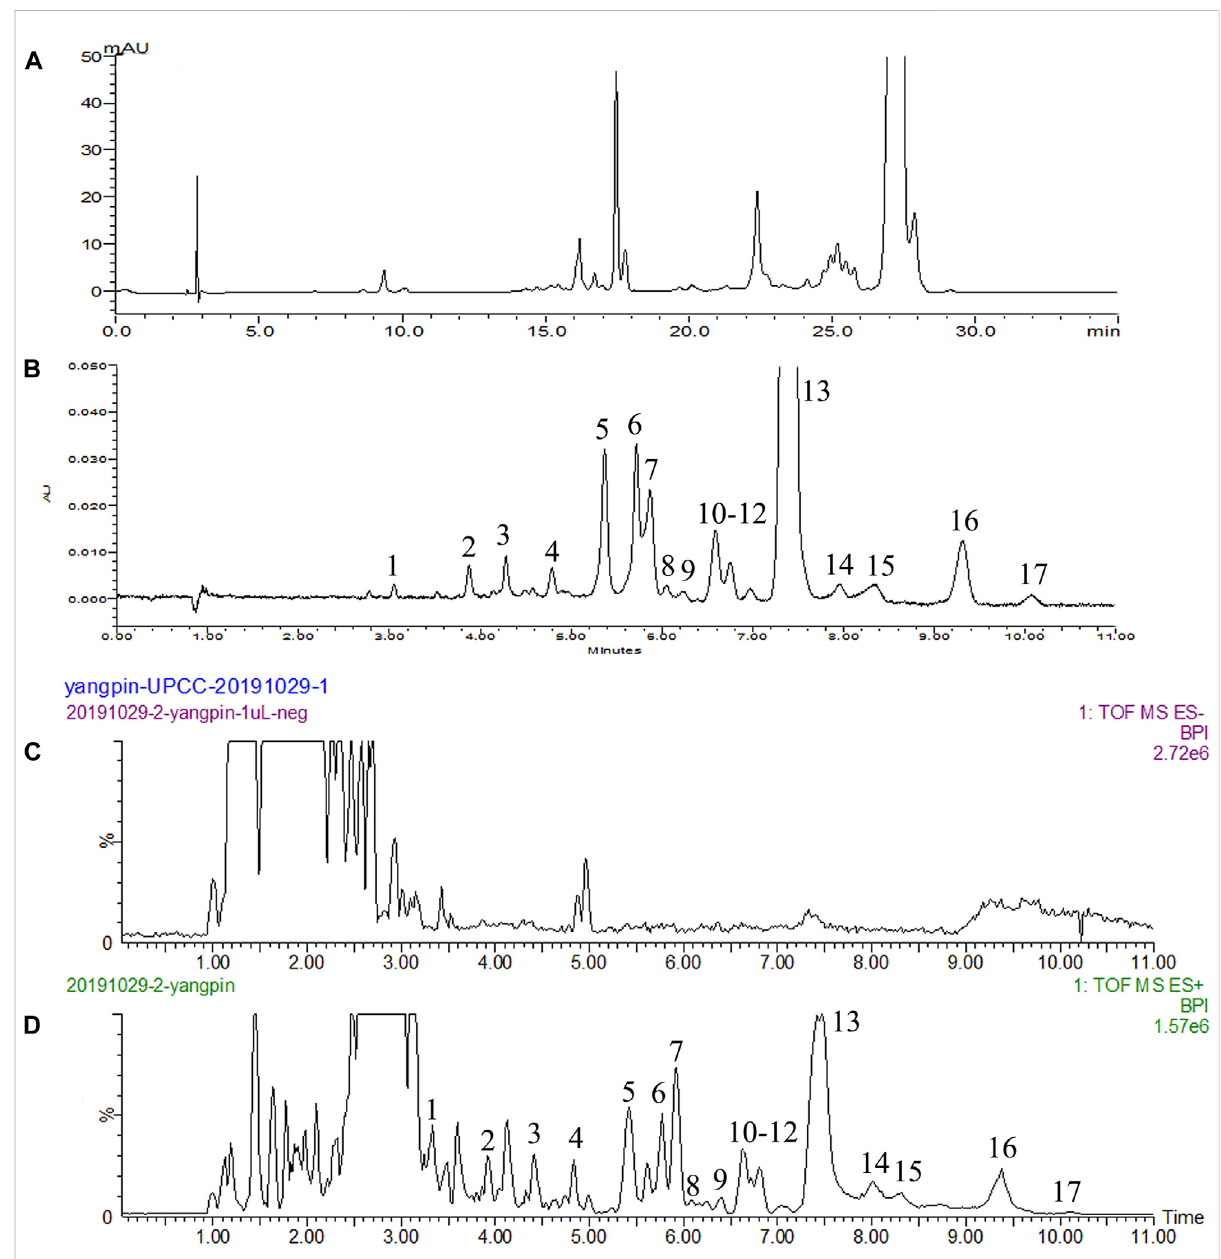
FIGURE 1 Typical chromatograms of Lycium carotenoids. (A) UPLC; (B) UPC 2 ; (C) negative MS E ; (D) positive MS E